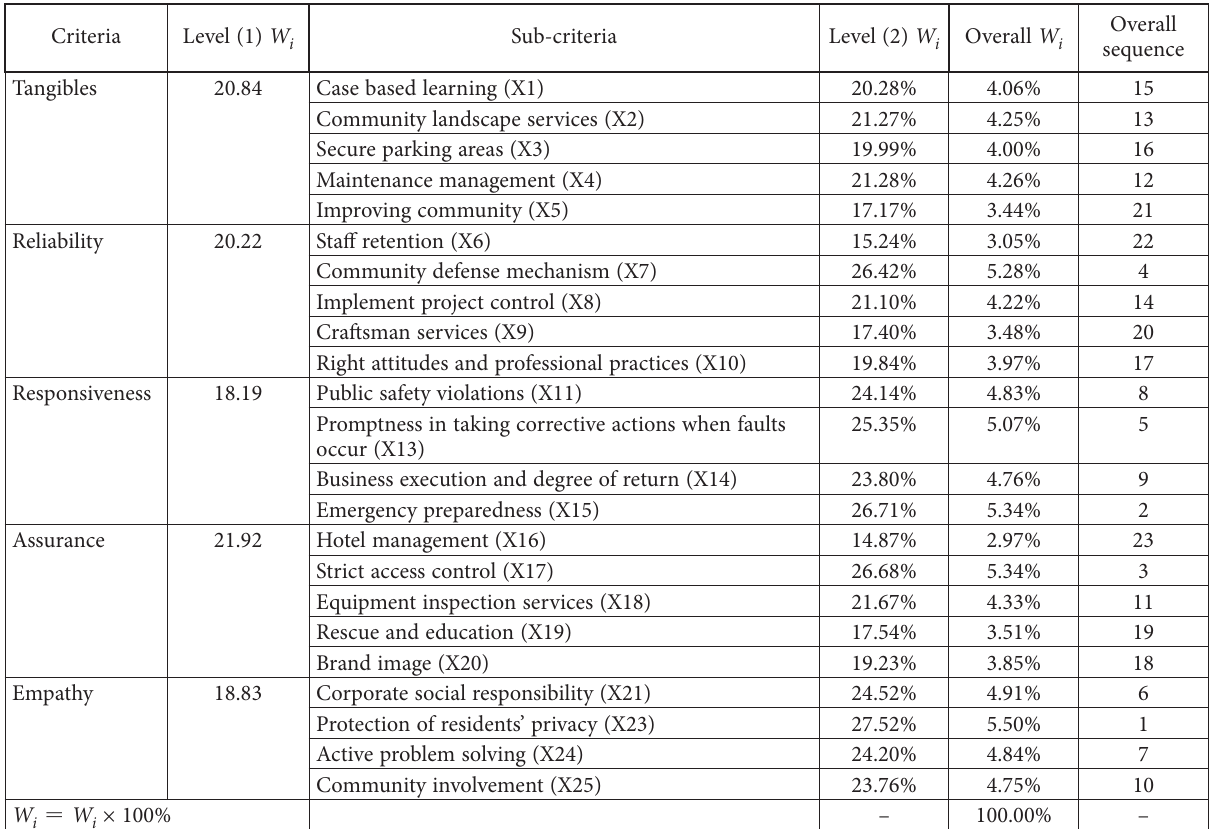
Table 4. Relative weights of major criteria and minor